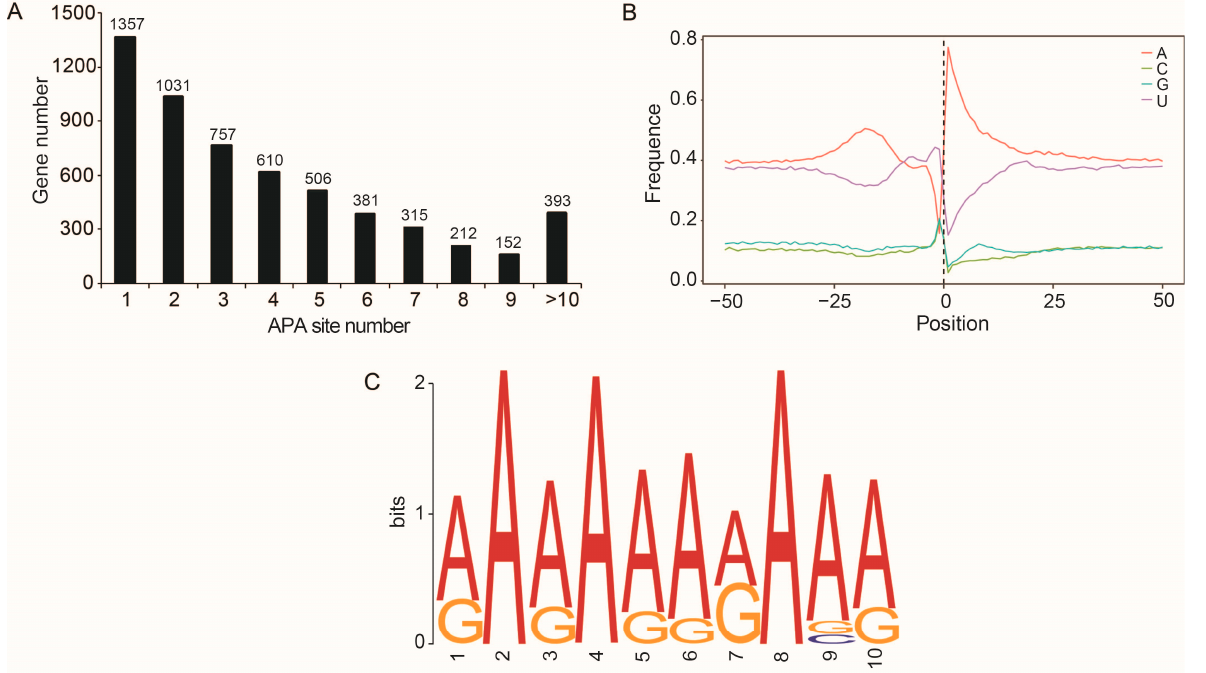
Figure 5. Alternative polyadenylation sites identified from the PacBio honey bee transcriptome. ( A ) Distribution of the number of APA sites per gene. ( B ) Nucleotide composition 50 bp upstream and downstream of the poly ( A ) sites. ( C ) A conserved element near the poly ( A ) sites predicted by MEME analysis.